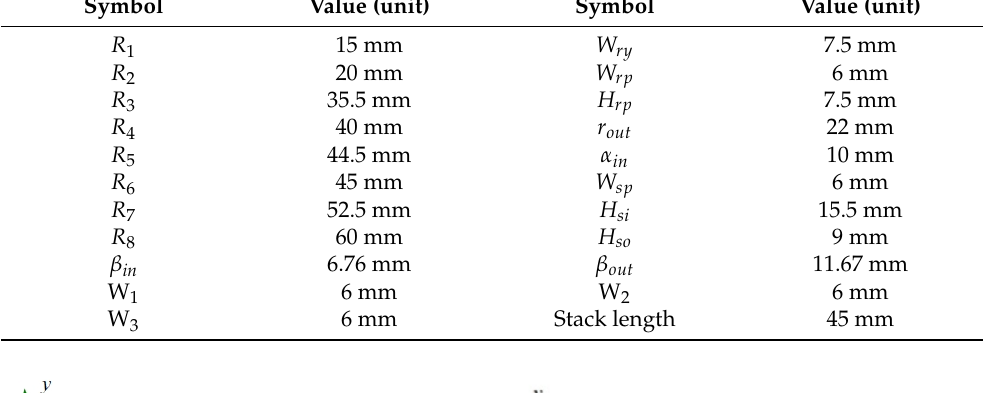
Table 1. Design parameter of proposed OR-FEFSM. Symbol